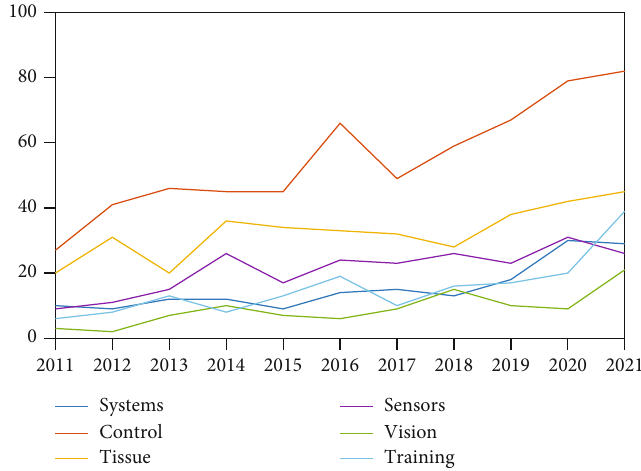
Figure 3: Temporal trends of Scopus results published between 2011 and 2021 using the proposed classi fi cation. Table 1: Comparison of di ff erent complete systems for tele-operated ultrasound scan